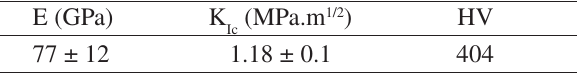
Table 1. Young’s modulus (E), fracture toughness (K microhardness (HV) values for 65 vol% porosity GR-HA speci- mens.